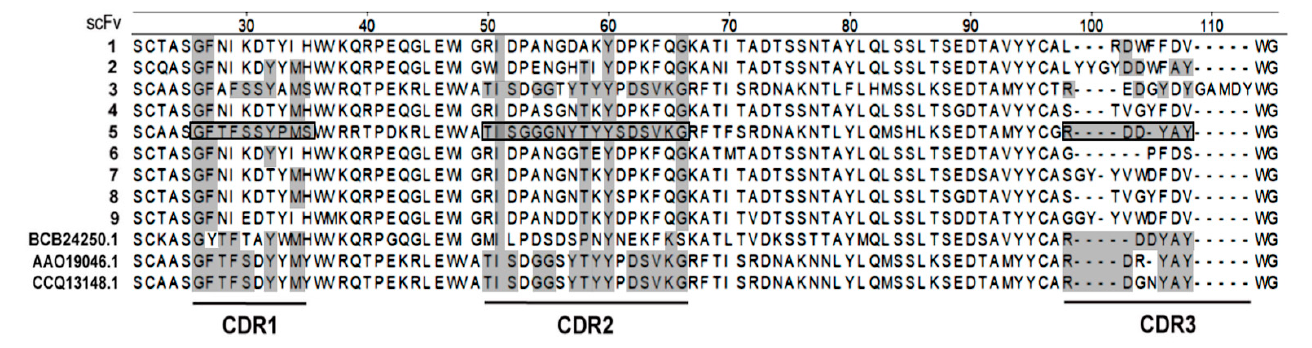
Figure 6. Analysis of CDRs (complementarity determining regions) of VH domains of selected recombinant Abs and three annotated in GenBank fragments with CDR3 most similar to scFv5 one. CDRs of scFv5 are framed, and identical a/a residues are marked with gray rectangles.